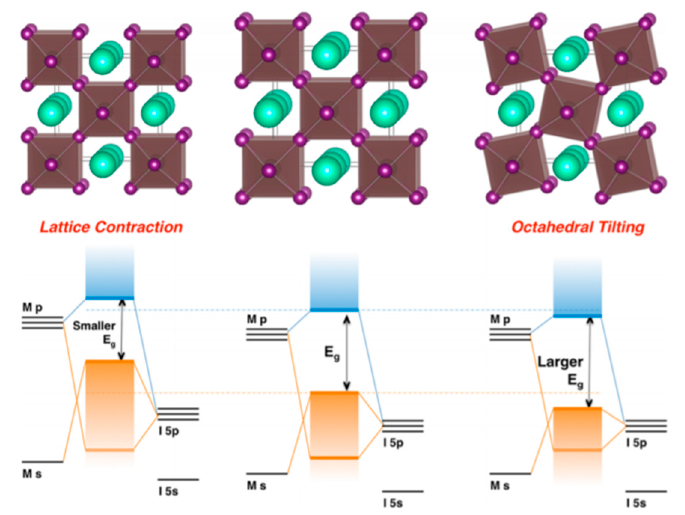
Figure 12. Perovskite lattice and energy levels of undistorted cubic phase (center), with lattice contraction (left) and with octahedral tilting (right). Reproduced with permission from J. Am. Chem. Soc. 2017 , 139 , 11117–11124 . Reference [42].